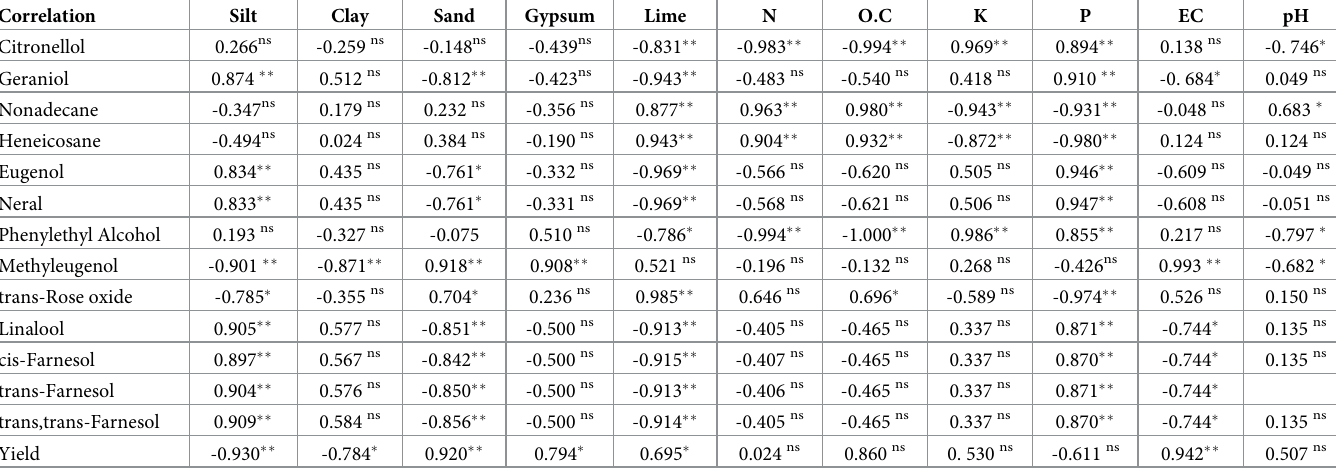
Table 5. Correlations between soil characteristics and yield and some dominant and important compounds in R . damascena EO.